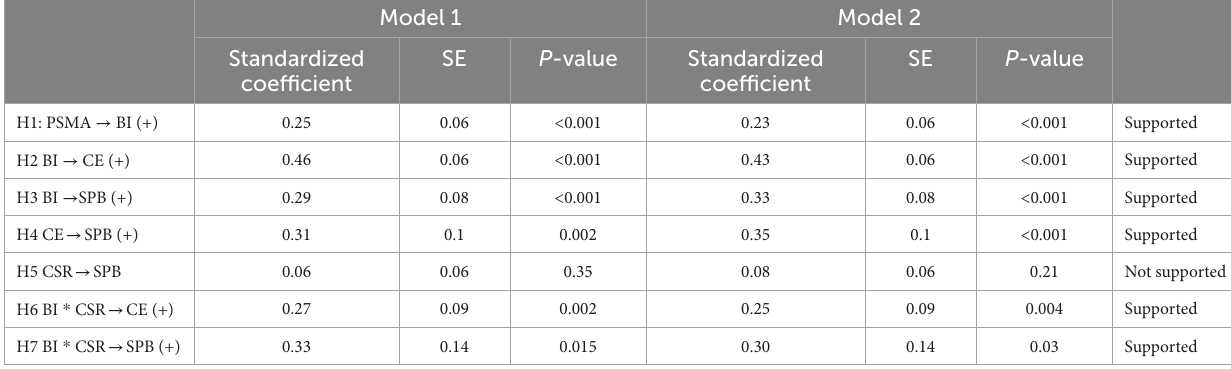
TABLE 3 Hypotheses